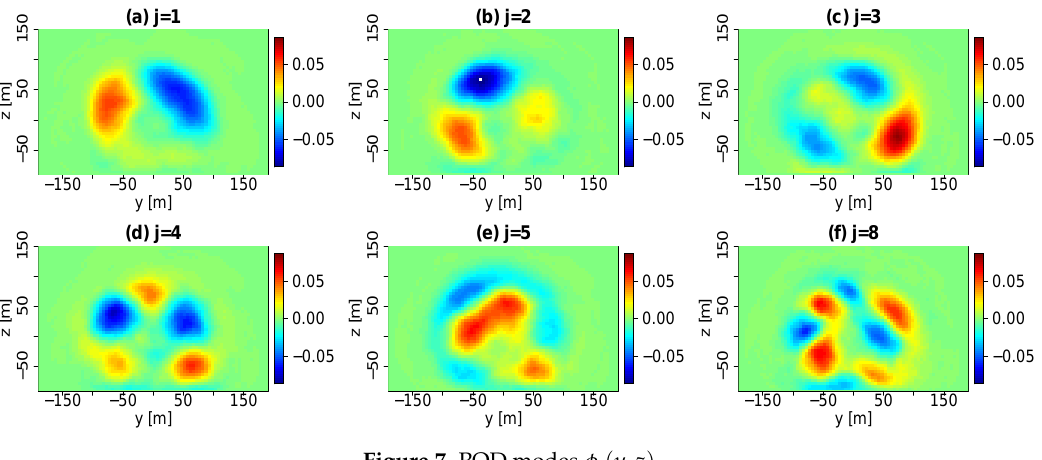
Figure 7. POD modes φ j ( y , z )